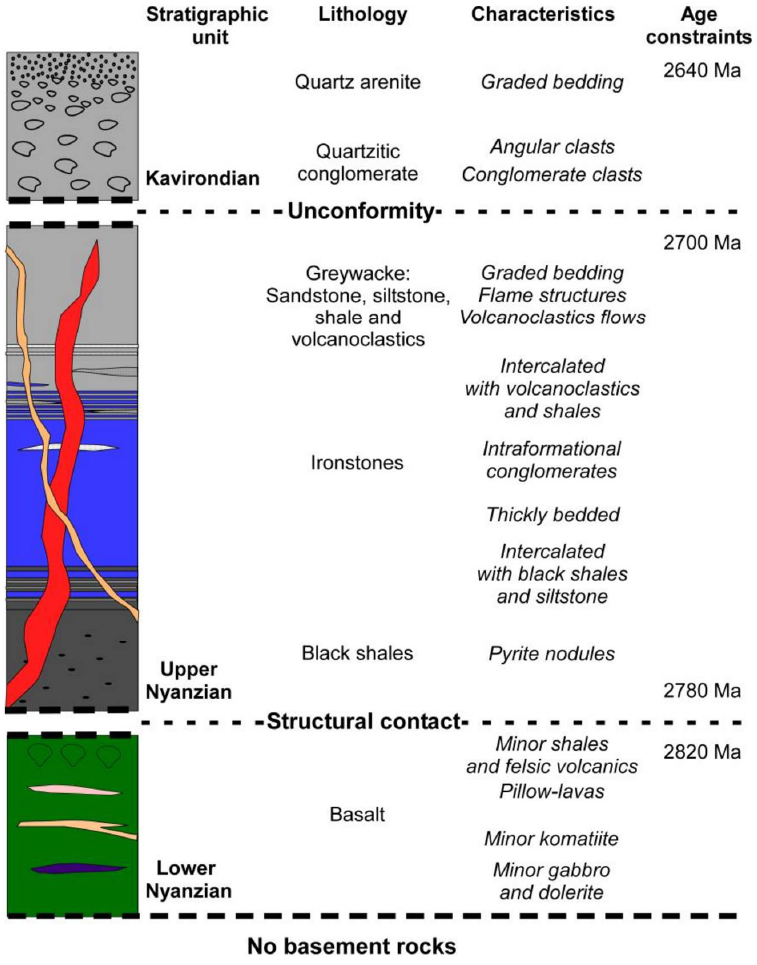
Figure 4. Summary stratigraphy for the Kukuluma terrain. Age constraints are from [28,37].